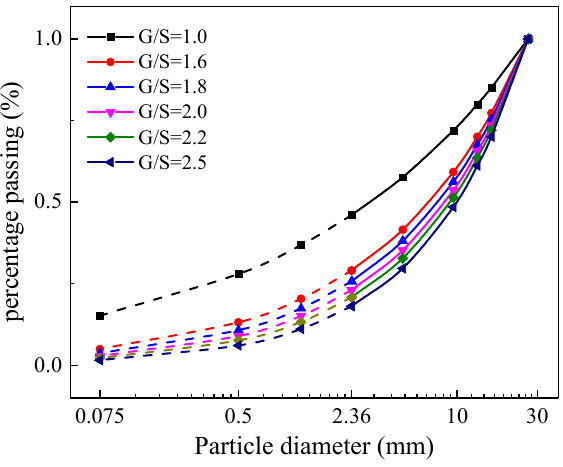
Figure 1 . Gradation curves of UPAB materials studied . Figure 1. Gradation curves of UPAB materials studied. Table 1. Gradation design scheme and corresponding gradation Table 1. Gradation design scheme and corresponding gradation parameters .